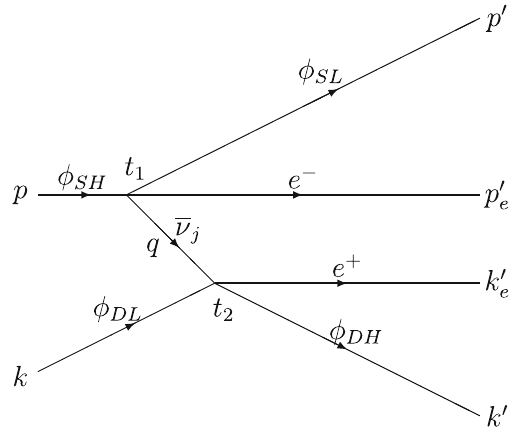
Fig. 2 Time flows to the right. A heavy source particle β -decays into a light source particle, an electron and a antineutrino. The antineutrino is absorbed by the light detector particle, which becomes a heavy detec- tor particle and emits a positron. The arrows indicate the signs of the